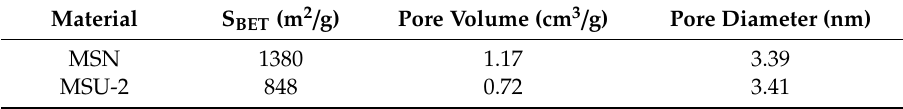
Figure 4. Nitrogen adsorption–desorption isotherms of MSN ( left ) and MSU-2 ( right ). Table 1. Textural parameters of MSN and MSU-2 obtained by nitrogen adsorption–desorption analysis.